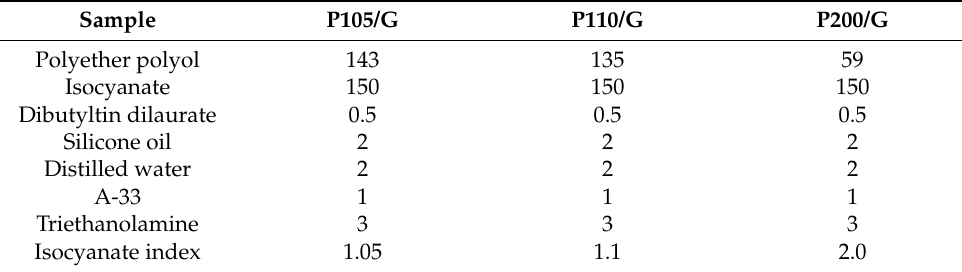
Table 1. The reagent used in the preparation of